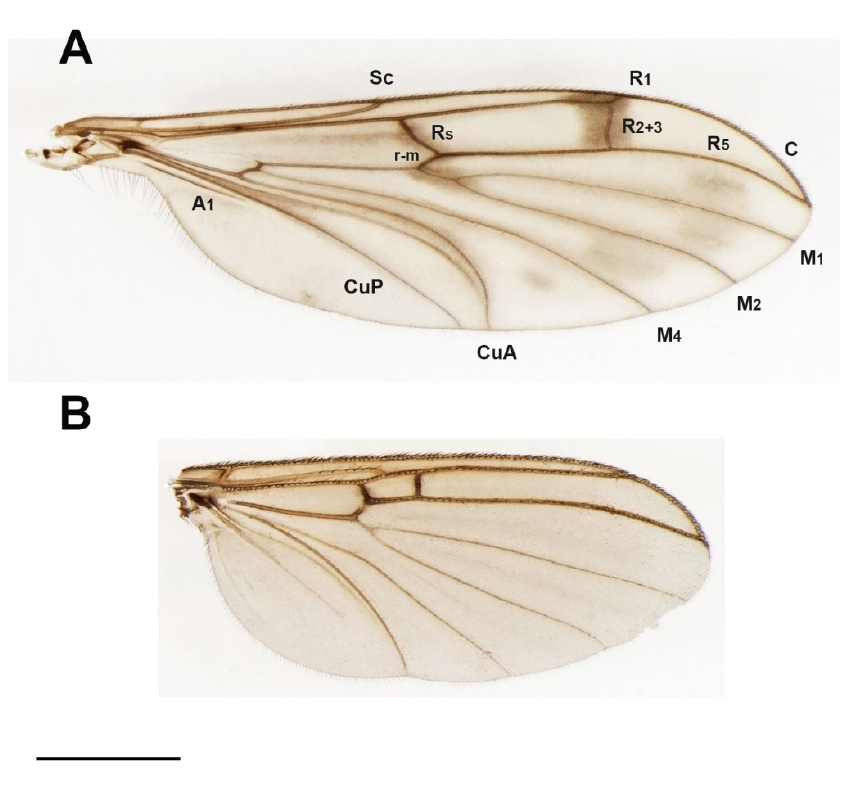
Figure 1. Wing photographs of two new extant species, with wing vein nomenclature indicated. ( A ). Bolitophila nikolae Šev č ík sp. nov. (holotype); ( B ). Hadroneura martini sp. nov. (holotype, male). Abbreviations of veins: C—costal vein; Sc—subcostal vein; Rs—radial sector; R 1 —anterior branch of radius; R 2+3 —branches of radius; R 5 —third branch of radius; r-m—radio-medial vein; M 1 —first branch of media; M 2 —second branch of media; M 4 —fourth branch of media; CuA—anterior cubital vein; CuP—posterior cubital vein; A1—first branch of anal vein. Scale bar: 1 mm.